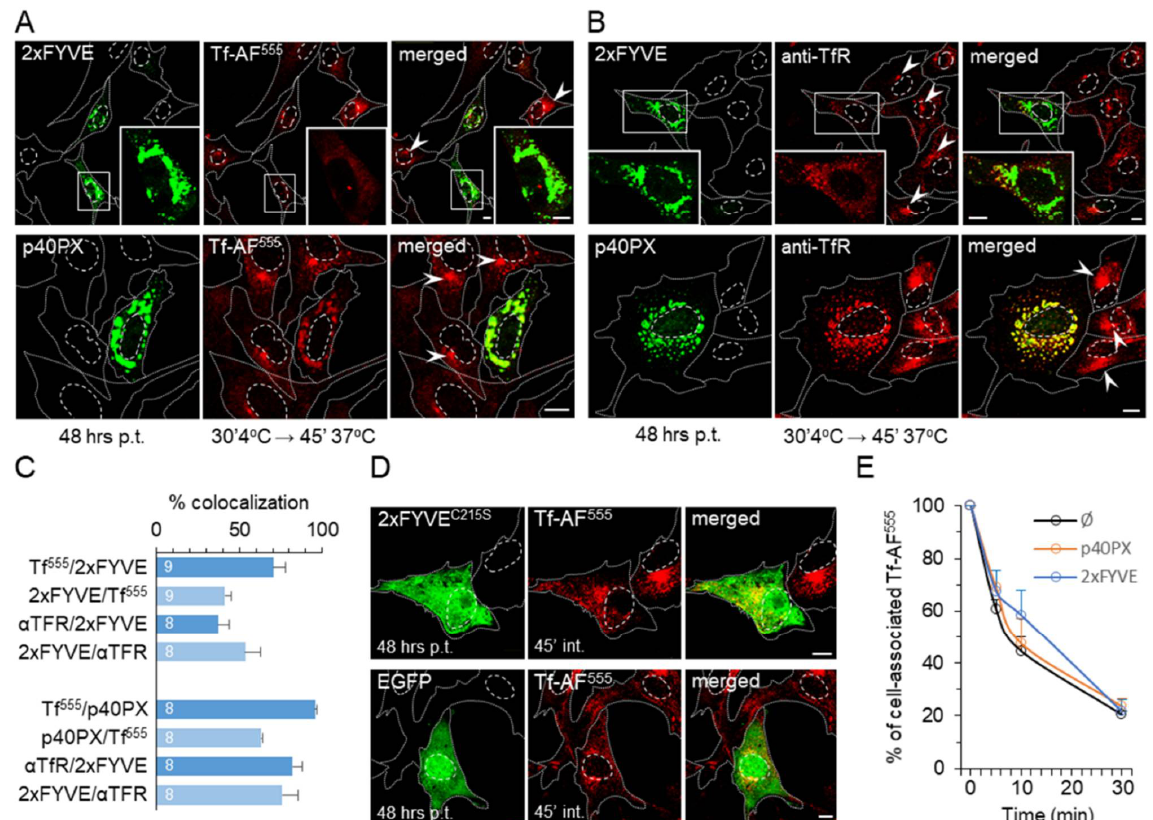
Figure 8. Prolonged expression of PI3P-binding domains alters TfR trafficking. Balb 3T3 cells were transfected with EGFP-2xFYVE MSCV or YFP-p40PX-MSCV and incubated 48 h post-transfection (p.t.) with Tf-AF 555 ( A ) or anti-TfR mAb ( B ) for 30 min at 4 °C, followed by 45 min of internalization at 37 °C and confocal imaging. Arrowheads indicate juxtanuclear accumulation of internalized TfRs. ( C ) The 3D colocalization of 2xFYVE and p40PX in high expressing cells with internalized Tf-AF 555 and mAb-TfRs based on the M1/M2 pixel overlap coefficients measured over the Costes-algorithm thresholded z-stacks of confocal images. Data are mean ± SEM per cell (number of cells indicated in bars). ( D ) Cells transfected with EGFP-2xFYVE C215S -MSCV or EGFP-MSCV were incubated with Tf-AF 555 for 45 min and analyzed by confocal imaging. Cell borders are indicated by fine dotted lines and cell nuclei by fine dashed lines. Bars, 10 µ m. ( E ) Kinetics of intracellular fluorescence loss by TfR recycling in untransfected (Ø) and EGFP-2xFYVE and YFP-p40PX transfected cells. The 48 h transfected cells were pulsed with hTf-AF 555 , chased in medium containing unlabeled hTf, and the intracellular fluorescence of transfected cells gated at the green channel was quantified by flow cytometry. Data represent mean ± SEM of five independent